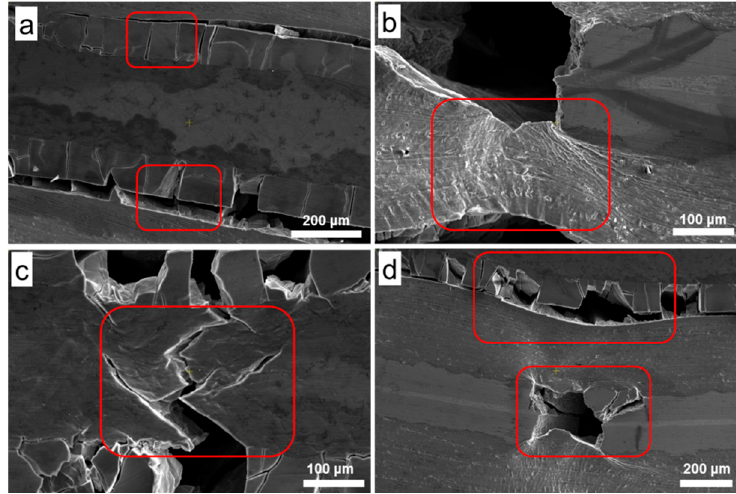
Figure 7. Crack morphology of four kinds of typical areas of AlMgTi-based bending sample: ( a ) Aluminum-magnesium diffusion layer; ( b ) Aluminum metal layer ( c ) Magnesium metal layer ( d ) Aluminum-titanium diffusion layer.